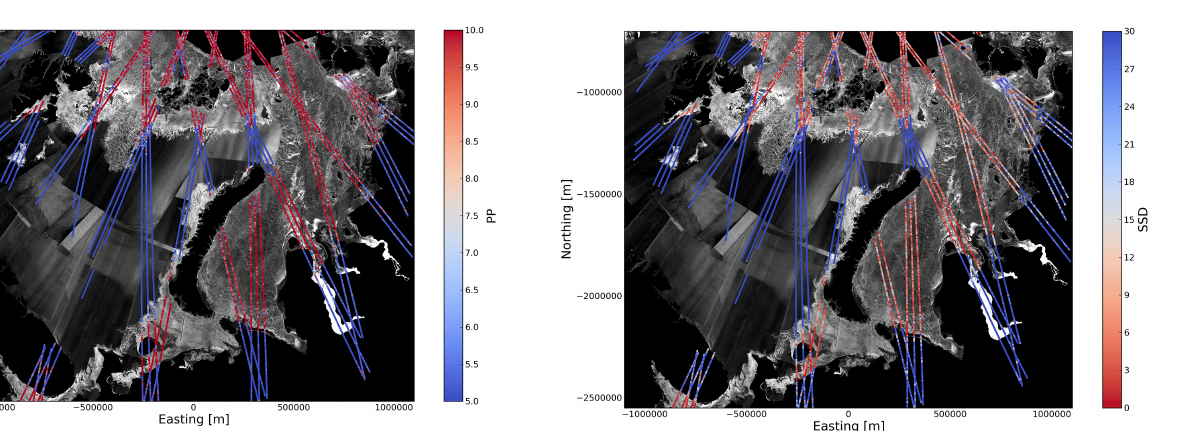
Figure 2. CS-2 stack standard deviation (1–5 March 2014) plotted on a RS-2 SAR composite (5 March